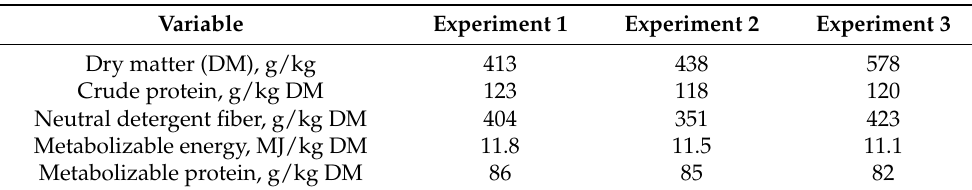
Table 1. Chemical compositions and feeding values of the total mixed rations used in experiments 1, 2, and